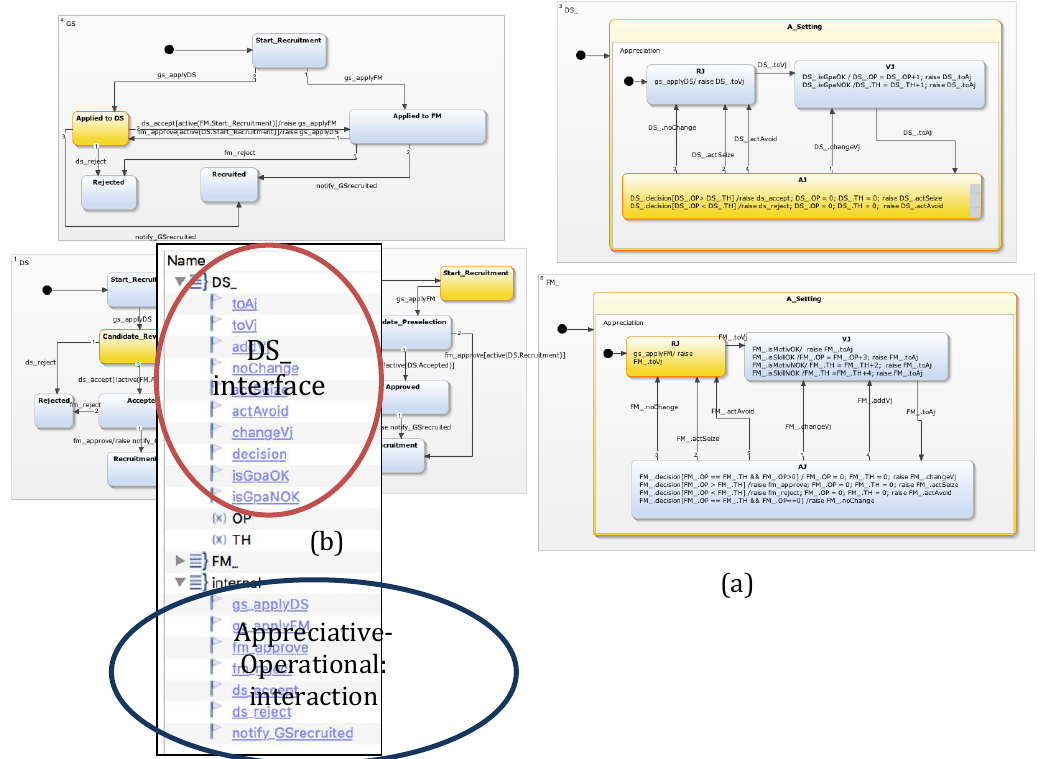
Figure 15. Simulation of the extended process model with